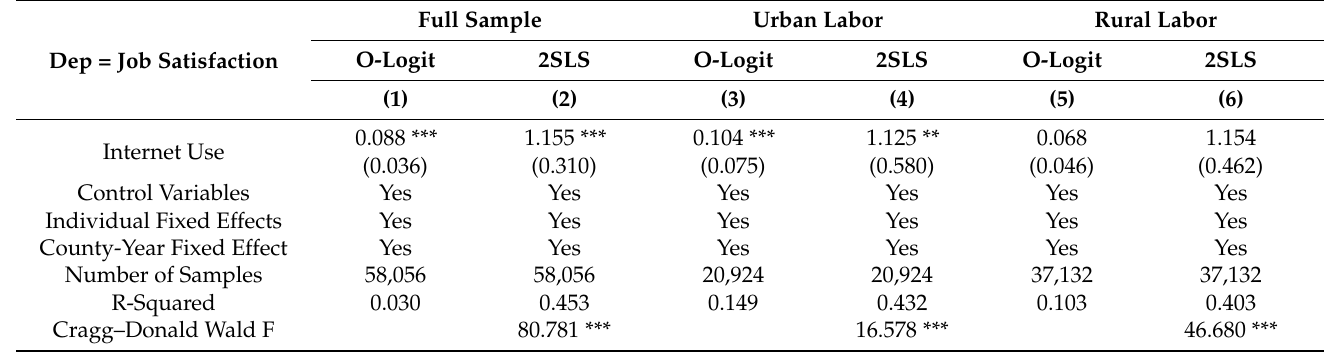
Table 8. Robustness Test: Only Retain a Sample of Respondents Who Participated in All Five